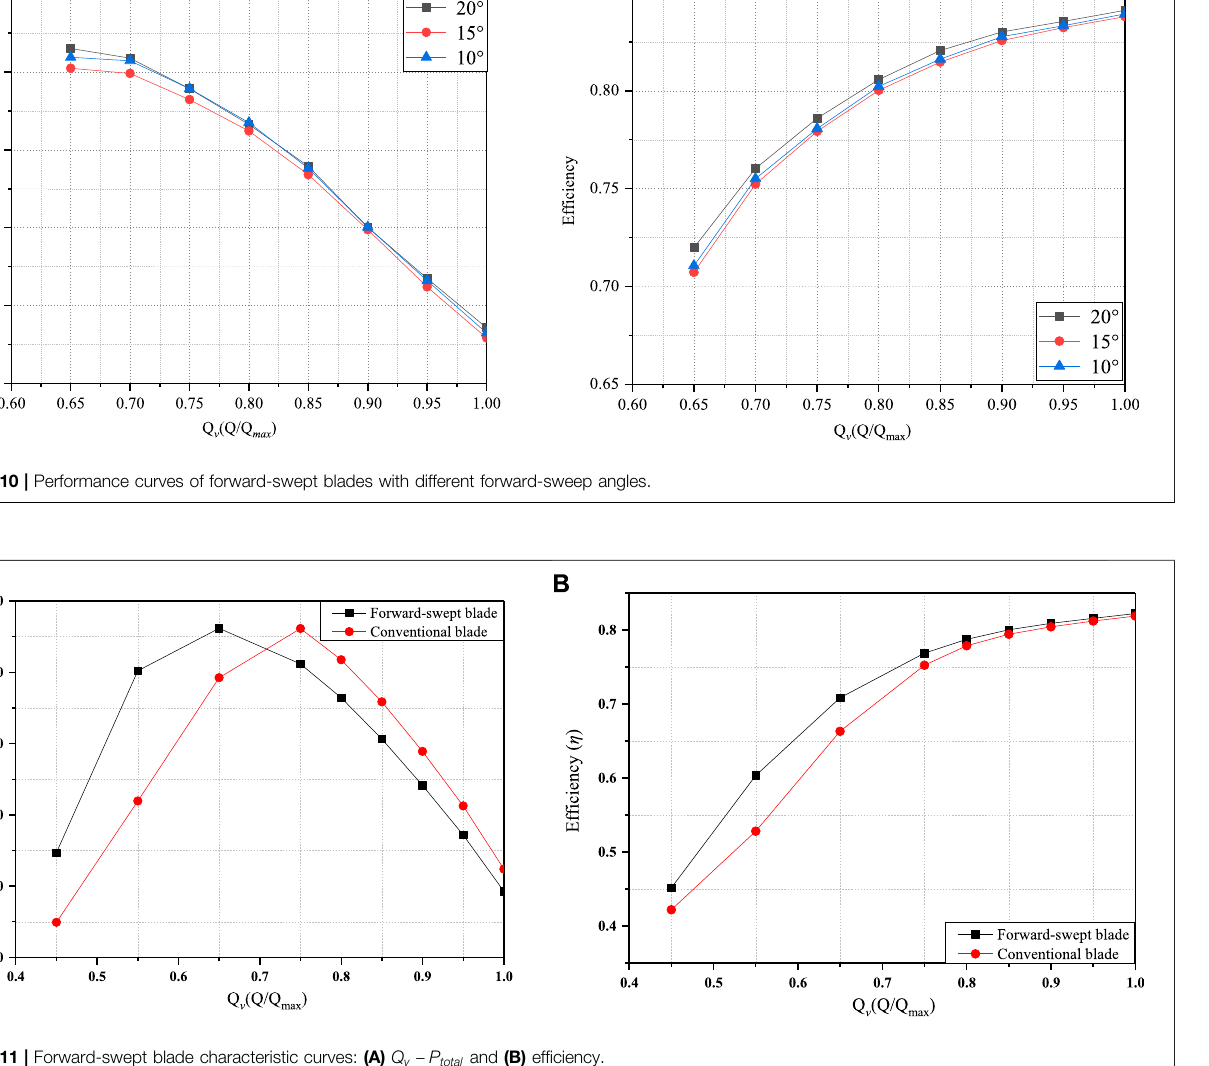
Frontiers in Energy Research |